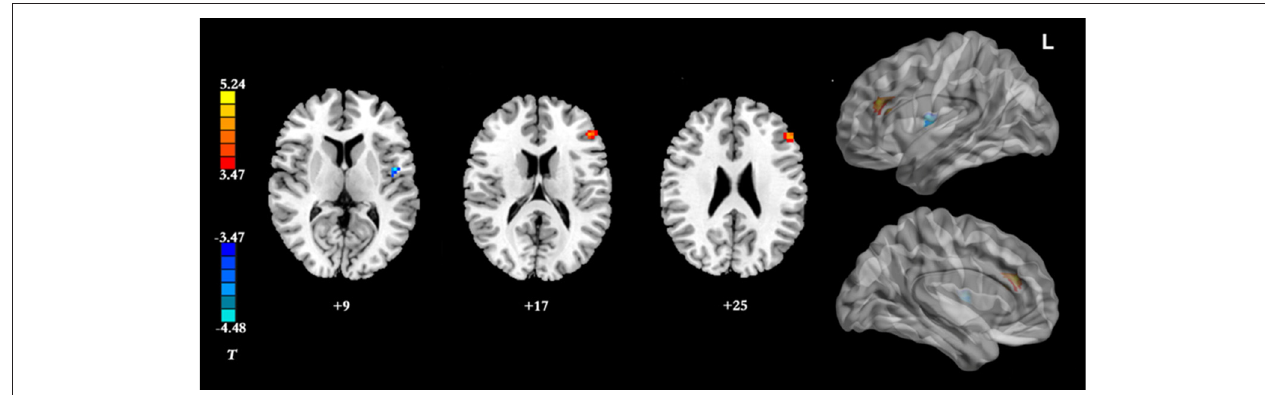
FIGURE 3 | Brain regions showing group differences between the IGD group and HC group in resting-state static FC with the right DLPFC as seed ROI ( p < 0.05, AlphaSim-corrected). Color bar, yellow (orange): regions showing significantly higher static FC, blue: regions showing significantly lower static FC. IGD, internet gaming disorder. HC, healthy control; DLPFC, dorsolateral prefrontal cortex; FC, functional connectivity.